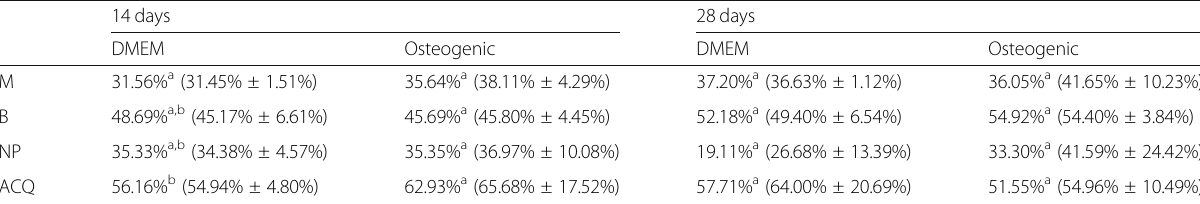
Table 4 Percentage of mineralized area produced by SC-EHAD cells at the different surfaces, according to culture media and periods of investigation [median (mean ± standard-deviation)]